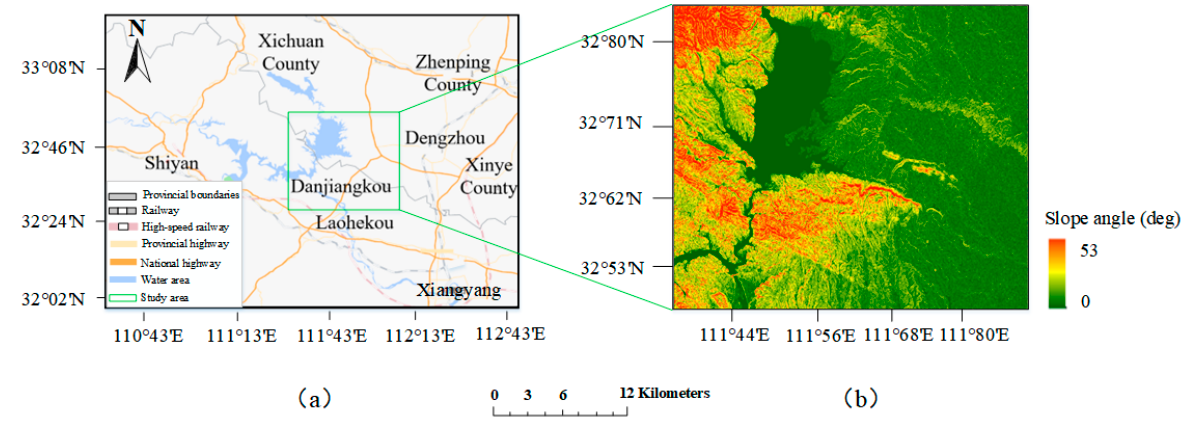
Figure 1. Study area: ( a ) Location map of study area; ( b ) Slope angle of the study area.